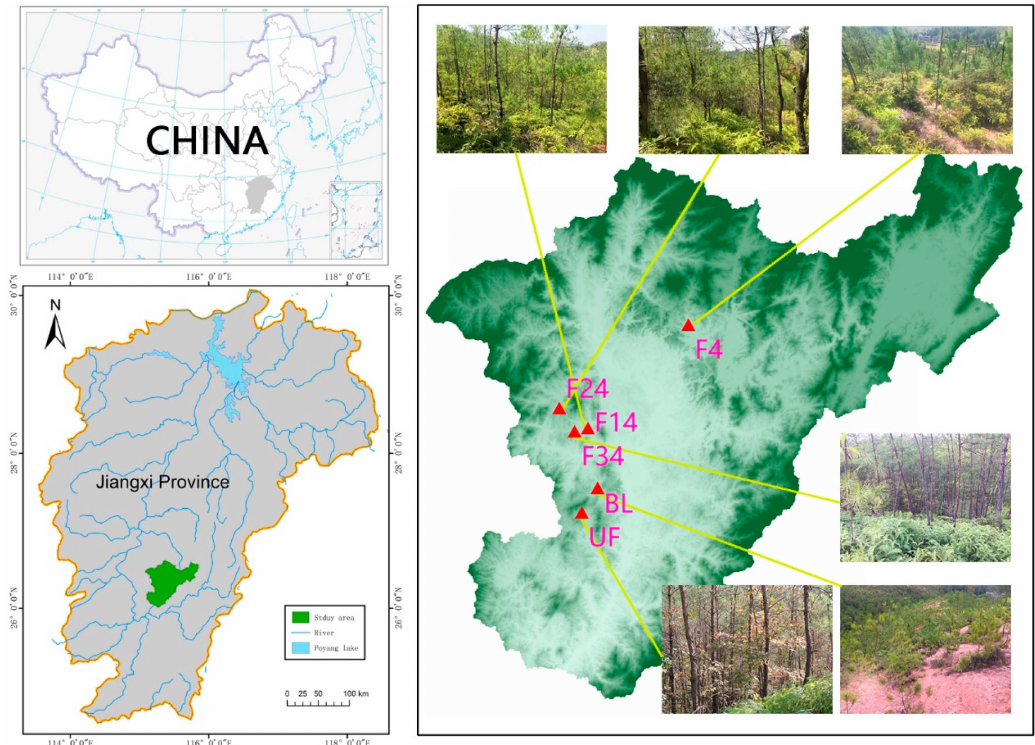
Figure 1. Location of study area and the distributions of six forest sites. BL: Bare land; F4, F14, F24, and F34: the forest sites of 4 years, 14 years, 24 years, and 34 years since the completion of combined measures; UF: nearly undisturbed old-growth forest